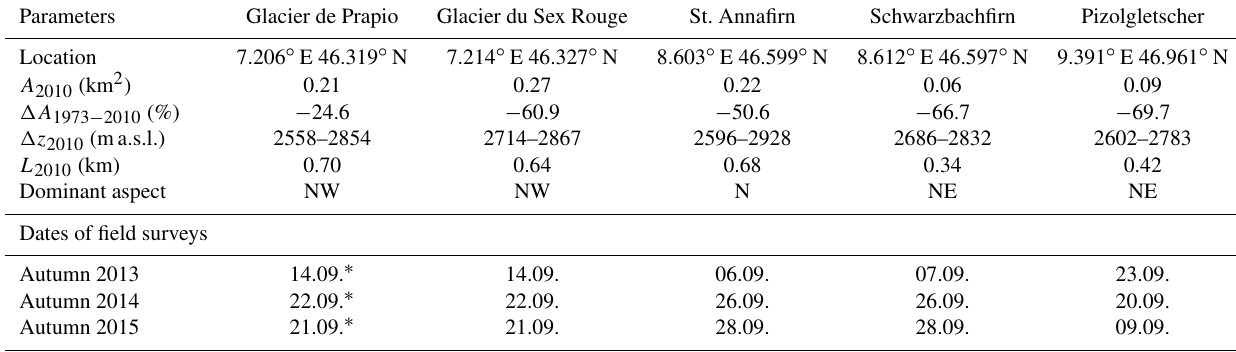
Table 1. Different parameters describing the characteristics of the five study sites listed from west to east: location, surface area in 2010 ( A 2010 ), relative area change between 1973 and 2010 ( (cid:49)A 1973 − 2010 ), elevation range ( (cid:49)z 2010 ) and length ( L 2010 ) in 2010, and dominant aspect from the Swiss Glacier Inventory 2010 (Fischer et al., 2014). In addition, the dates of the field surveys are given. Parameters Glacier de Prapio Glacier du Sex Rouge St. Annafirn